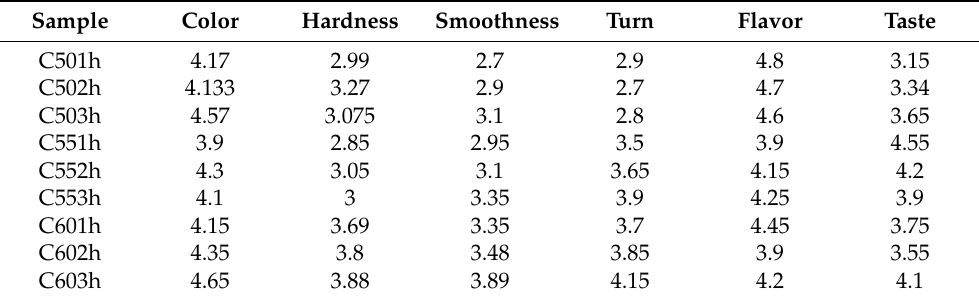
Table 4. Overall sensory evaluation of the tested CMM using the five-point method (the abbreviations used in the graph are described in Section